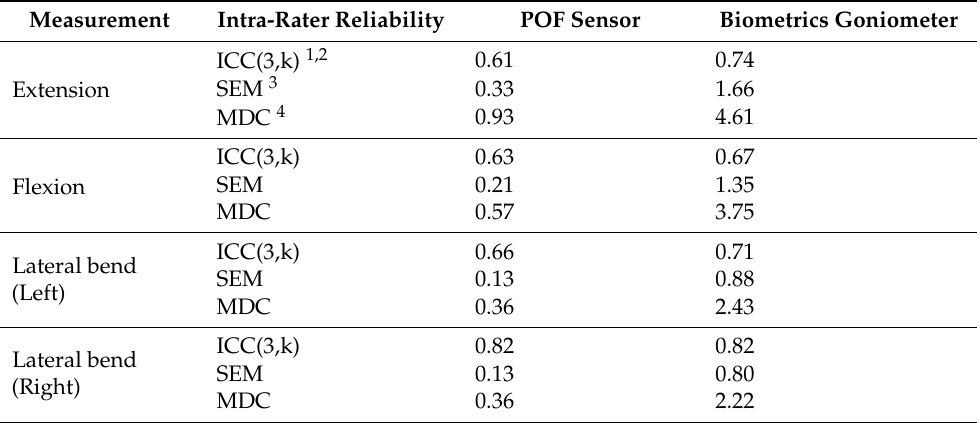
Table 2. Intra-rater reliability of the POF sensor and Biometrics goniometer.